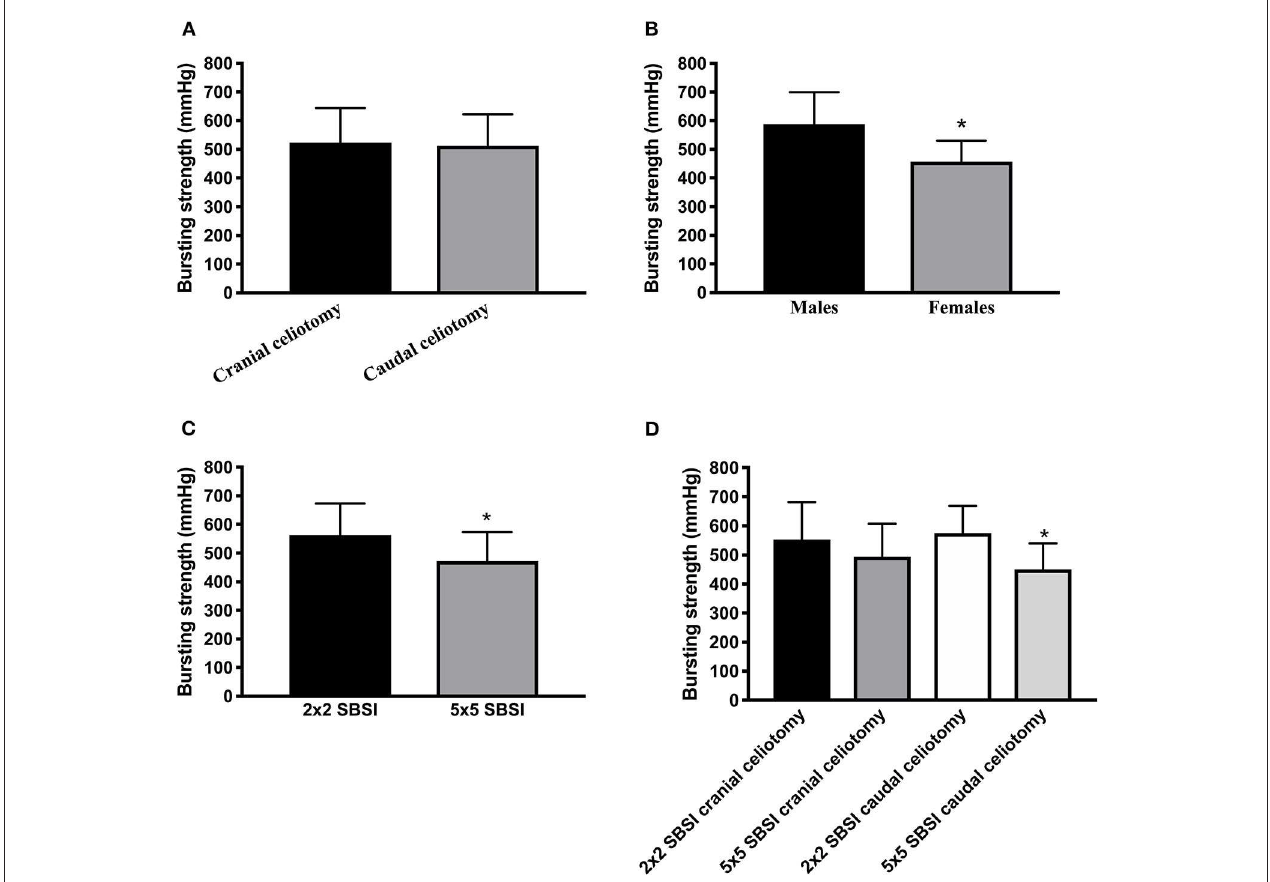
FIGURE 3 | (A) Bursting strength of cranial and caudal celiotomies. (B) Bursting strength of males and females. (C) Bursting strength for small and large SBSI. (D) Bursting strength for celiotomy location and SBSI. *Statistical significant P < 0.05.